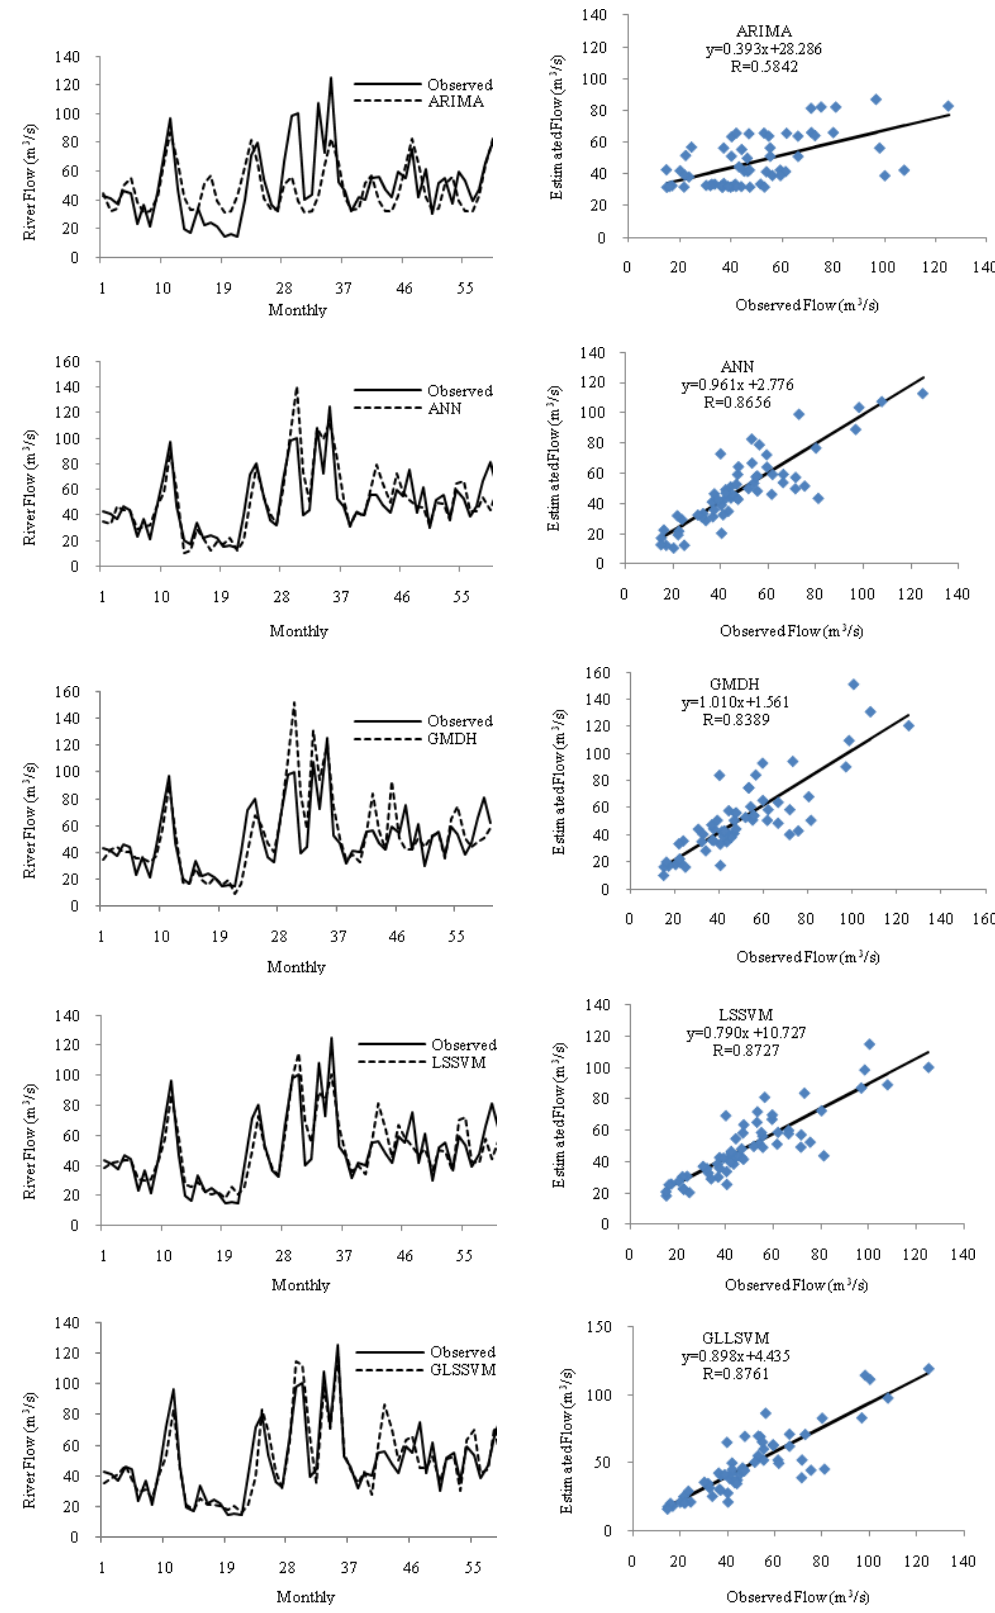
Fig. 10. Comparison of the testing results of ARIMA, ANN, GMDH, LSSVM and GLSSVM 6 models for Bernam river 7